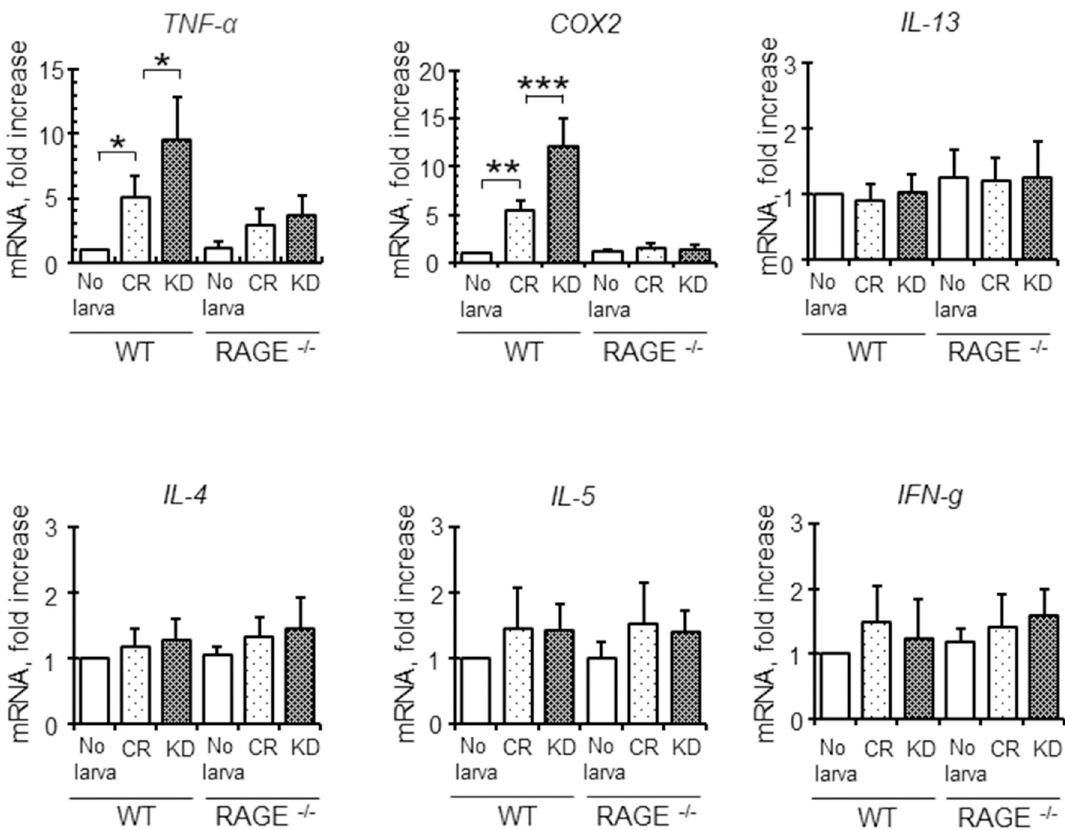
Fig 6. Effects of endogenous venestatin on cytokine production in mouse skin tissues. Quantitative RT-PCR analysis of pro-inflammatory molecules from skin tissues of wild-type (WT) or RAGE-null (RAGE -/- ) mice was performed. Total RNA was extracted from mouse skin tissues at the larva inoculation site at 6 h p.i. with 2,000 LL3s treated with ds luciferase (CR) or ds venestatin (KD). The mouse GADPH gene was used to normalize the amount of cDNA, and the expression level in na ï ve skin (no larva) was set as 1. Data are expressed as means ± SDs of three independent experiments with two technical replicates. � p < 0.01; �� p < 0.001; ��� p < 0.0001.